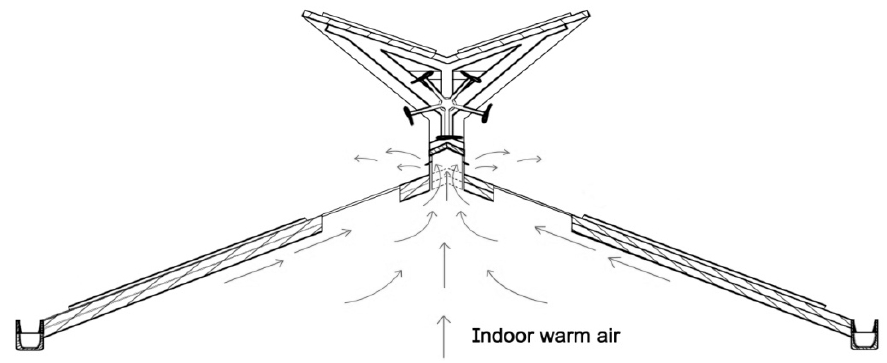
Figure 9. Schematic diagram of ventilation.